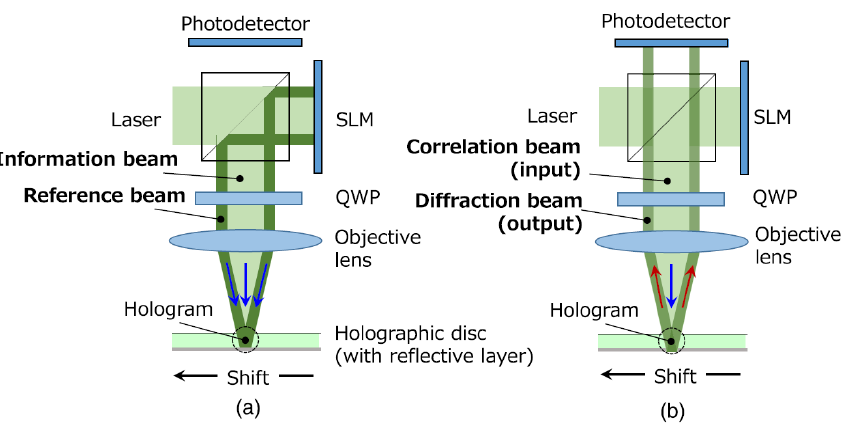
Figure 6. The holographic optical correlator: ( a ) the recording part; ( b ) the correlation part. QWP: quarter wave plate; SLM: spatial light modulator